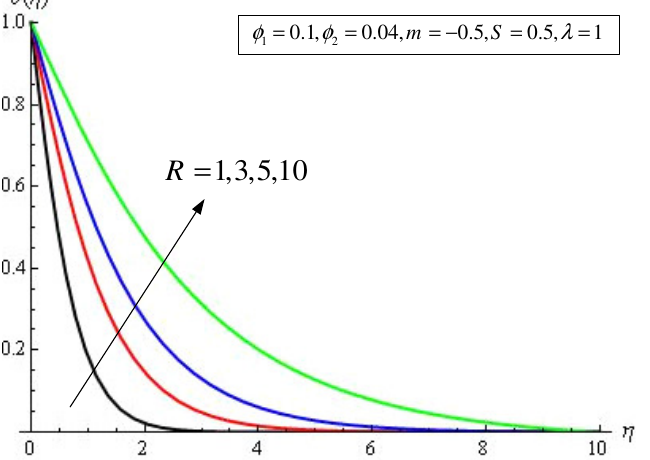
Figure 5. Influence of the thermal radiation parameter R on the temperature